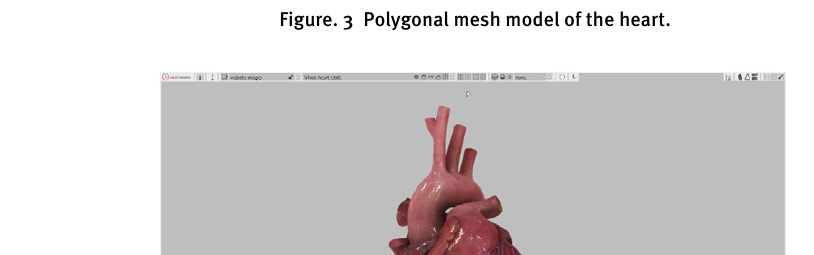
Figure. 3 Polygonal mesh model of the heart.